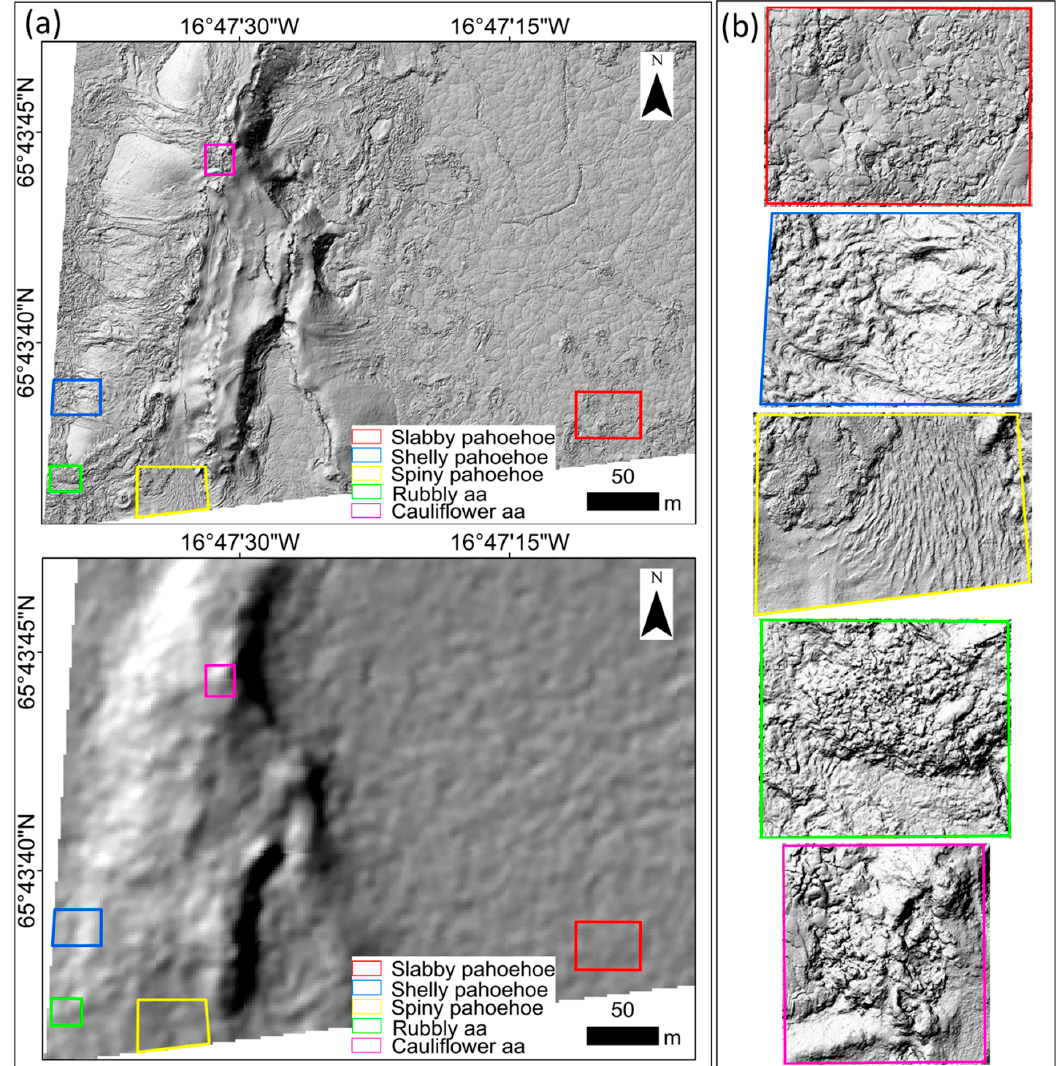
Figure 4. Visual comparisons: ( a ) between hillshaded views of 2 cm/pixel UAV DTM and 2 m/pixel ArcticDEM [68] (courtesy: Polar Geospatial Center); and ( b ) among various lava flow morphologies in 2 cm/pixel hillshaded UAV DTM. The quadrilaterals in ( a ) provide contextual information for ( b ), Figures 6 and 7.